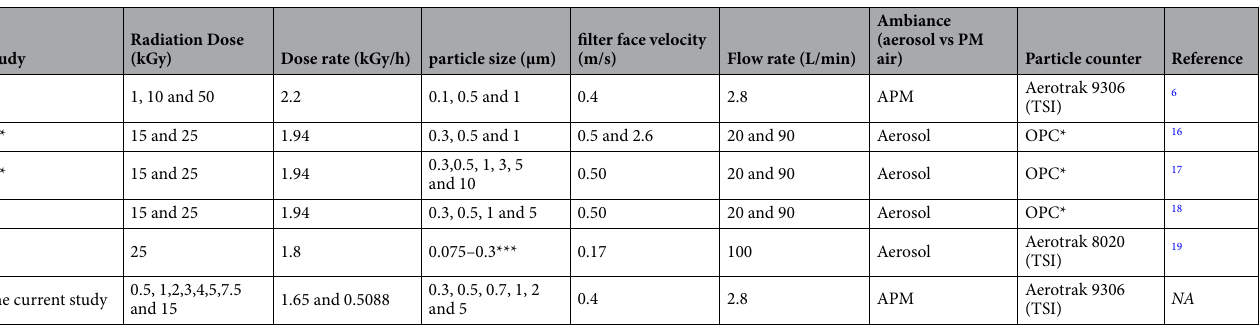
Table 2. Comparison between the parameters used in five studies investigating the filtration efficiency of FFRs following gamma irradiation. *Optical Particle Counter (Model 1.108, Grimm Aerosol Technik, Germany). **Preprinted study. ***Continuous